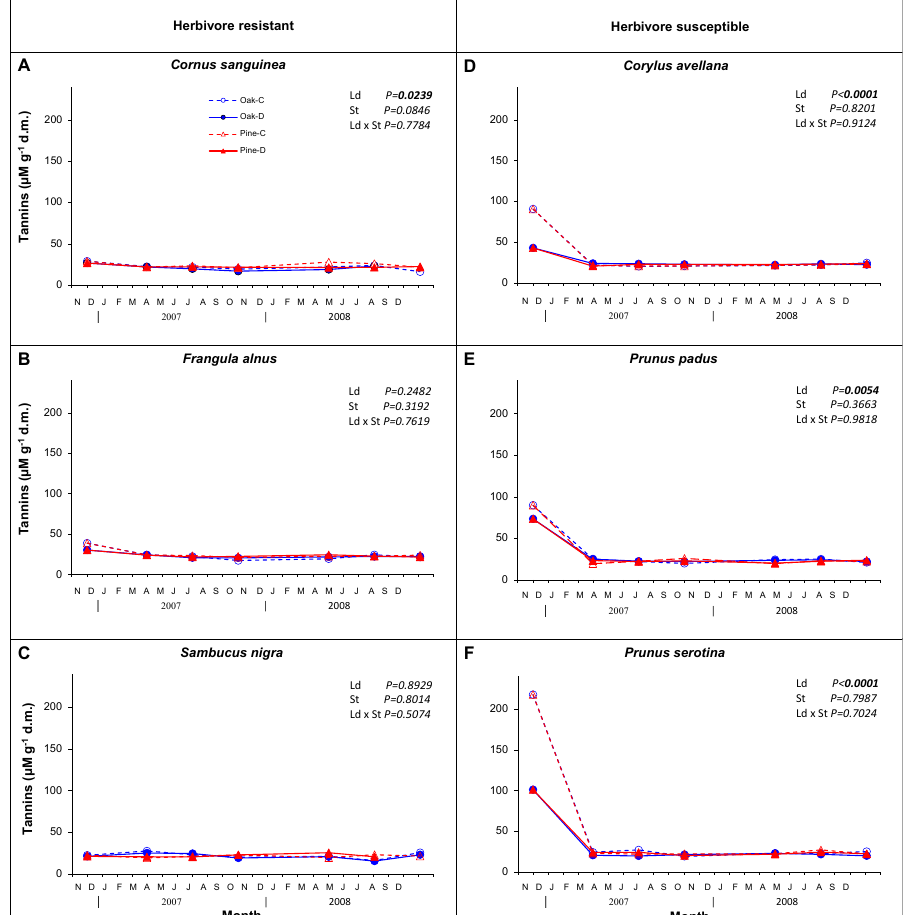
Figure 4. Changes in content of tannins (expressed as μ M of catechin g -1 d.m.) in leaf litter of six understory plant species (herbivore resistant species: Cornus sanguinea —( A ), Frangula alnus —( B ), Sambucus nigra —( C ), on the left and herbivore susceptible species: Corylus avellana —( D ), Prunus padus —( E ), Prunus serotina —( F ), on the right), depending on leaf damage (Ld; control (C) and damaged (D)) in two stand species (St; oak and pine monocultures).